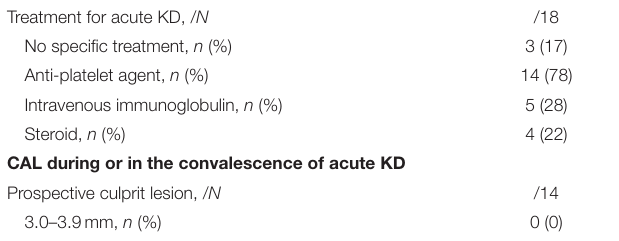
TABLE 3 | Treatment for acute KD and culprit lesions early and ≥ 5 years after acute KD. Treatment for acute KD, /